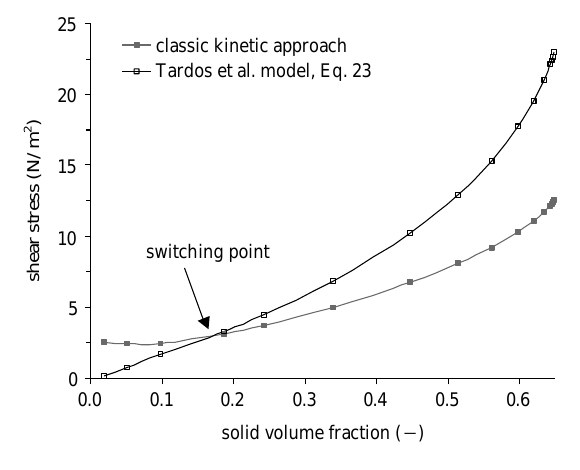
Switching between classic kinetic and Tardos et al. (2003) shear stress expression, a modelling approach employed by Makkawi and Ocone